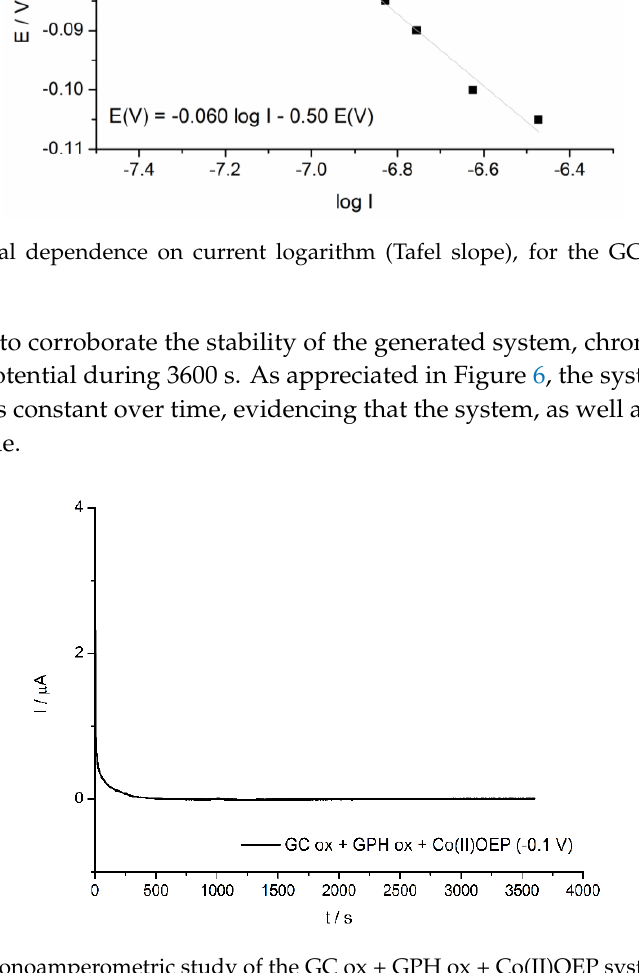
Figure 6. Chronoamperometric study of the GC ox + GPH ox + Co(II)OEP system stability.